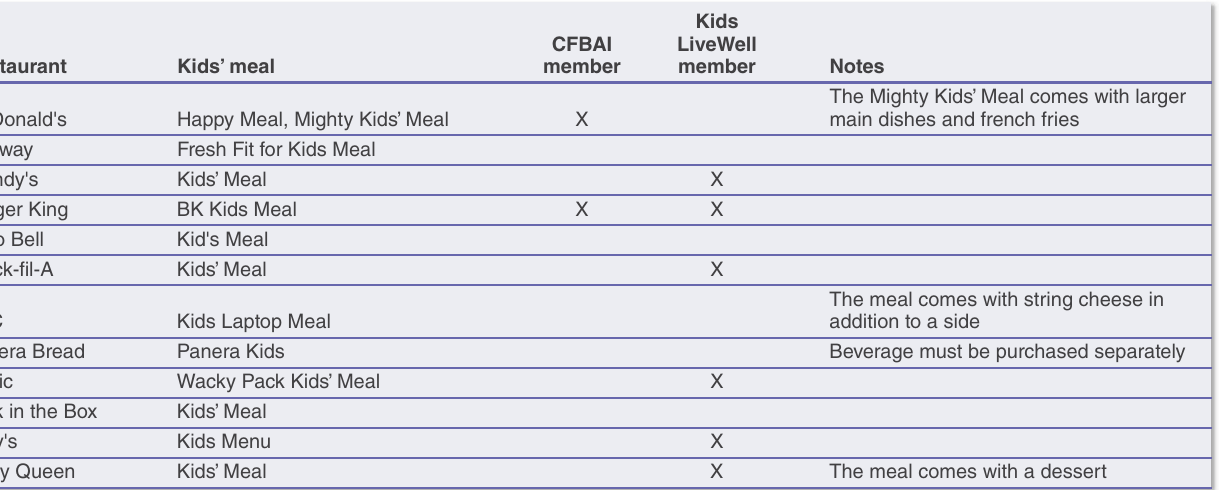
Table 4. Kids’ meals offered by